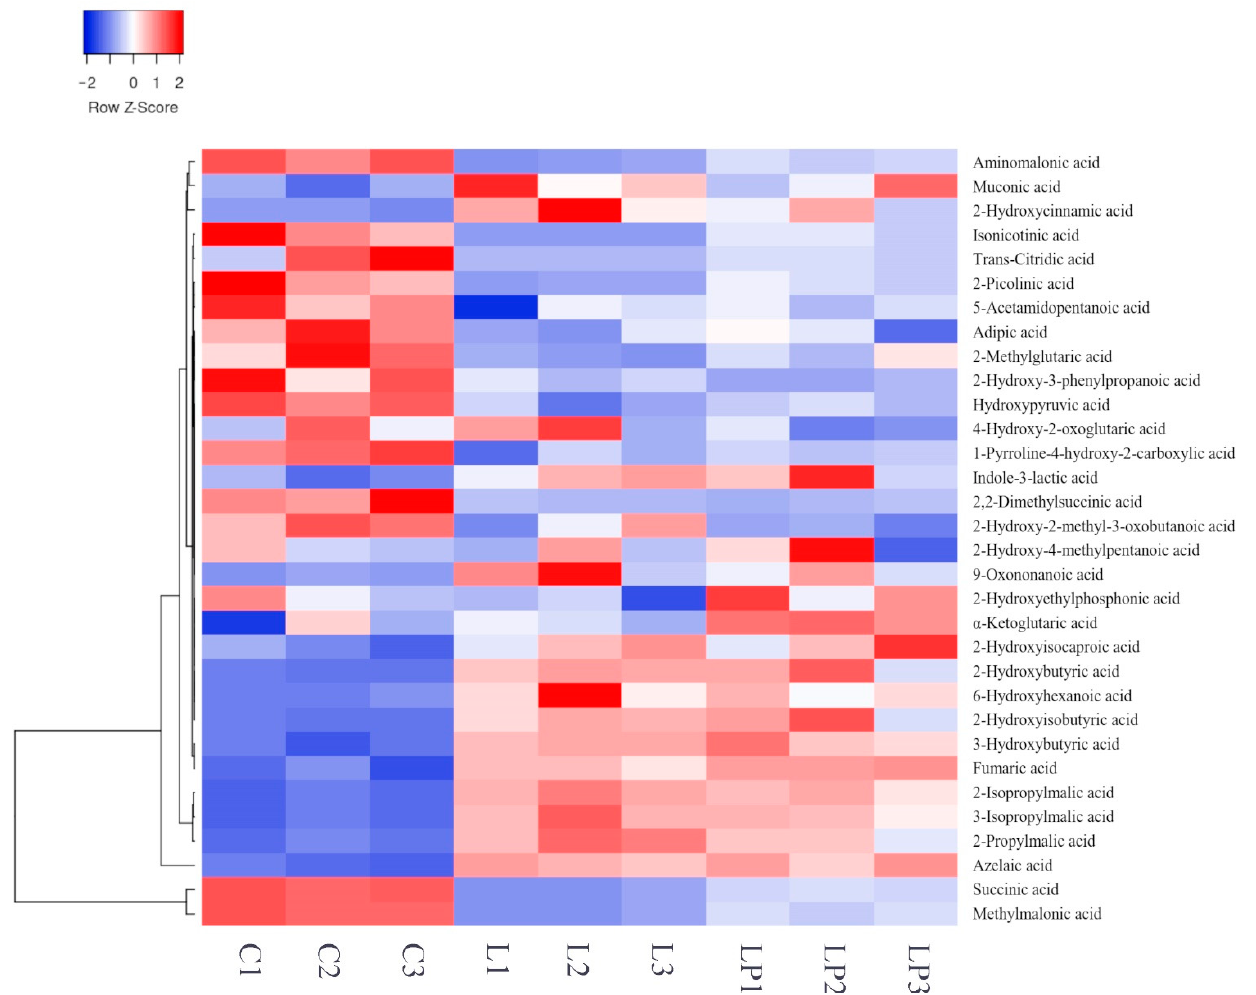
Figure 12. Heatmap and dendrogram of organic acid metabolites in embryos of maize under exoge- nous proline and low-temperature stress treatments.